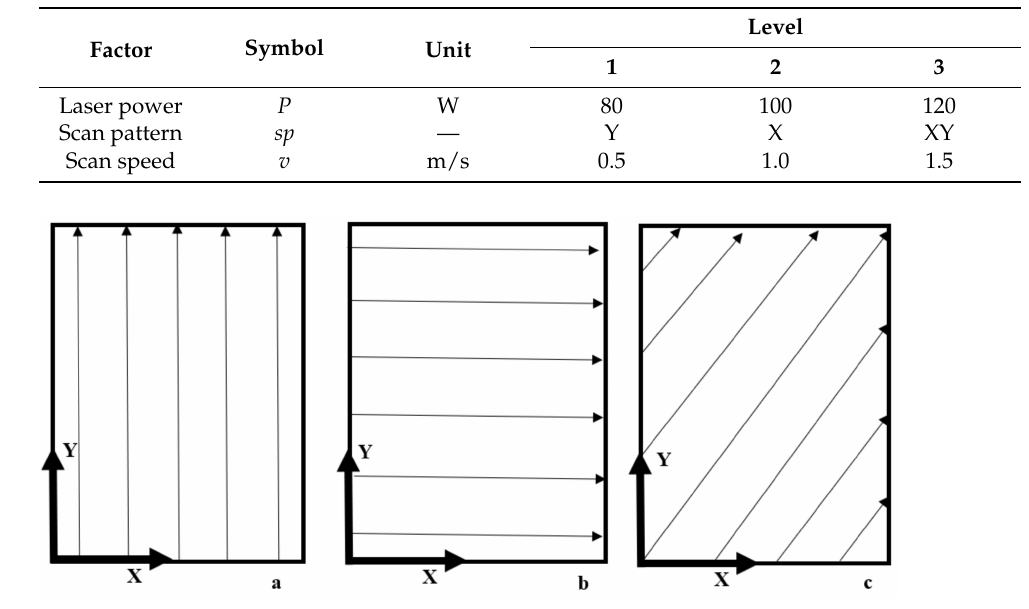
Figure 2. Scan pattern ( a ) Y-scan ( b ) X-scan ( c )